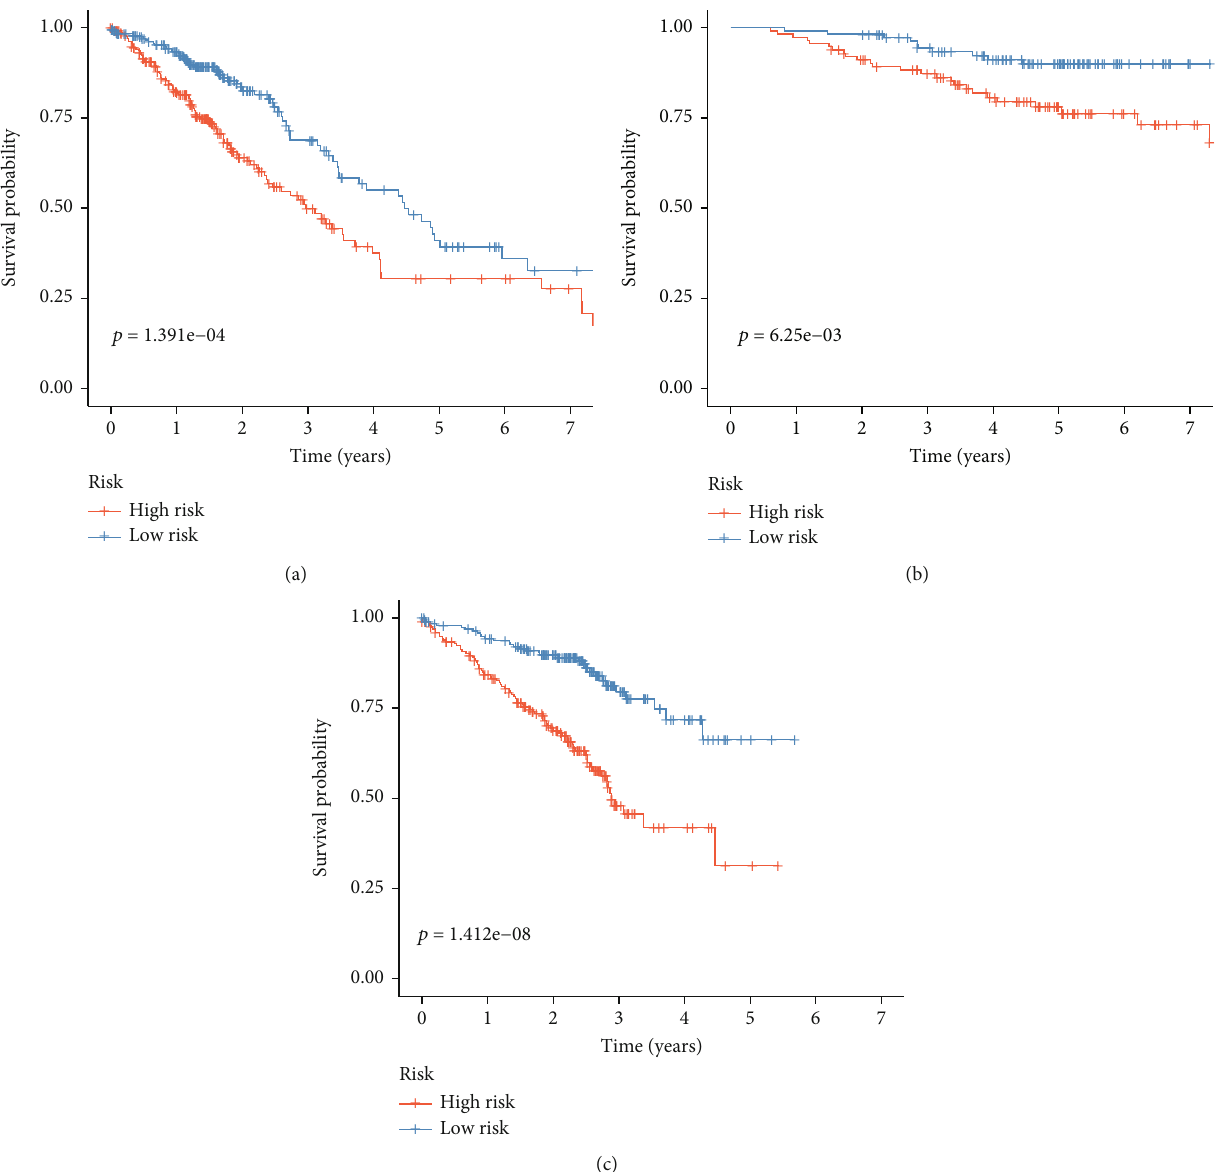
Figure 3: Survival analyses of HR and LR groups. (a) TCGA-LUAD. (b) GSE31210. (c)